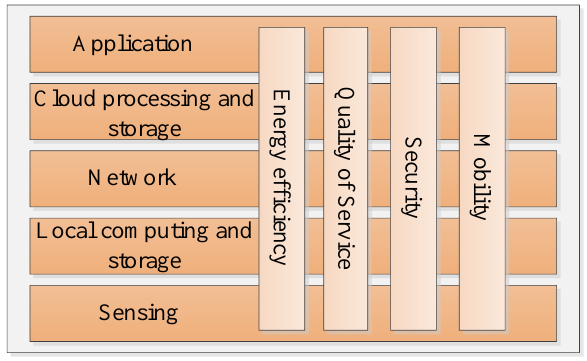
Figure 21. Cross layer interoperability.